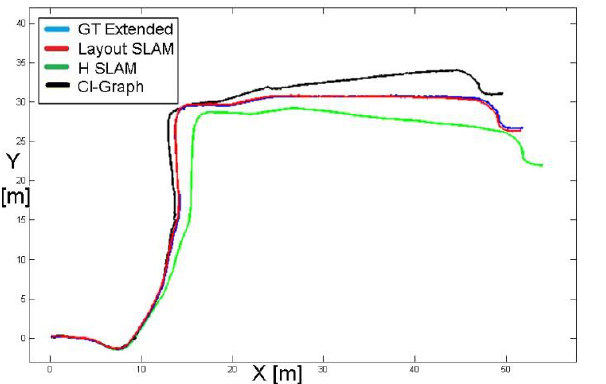
Figure 6. Results of different SLAM algorithms (trajectories) aligned with the ground truth (blue trajectory) for the first three corridor scenes of Biccoca_2009-02-25b , data set.